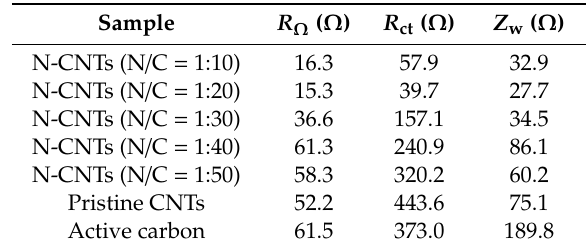
Table 1. Summary of the electrochemical impedance spectroscopy (EIS) tests in the Li–air batteries before discharge–charge cycling.